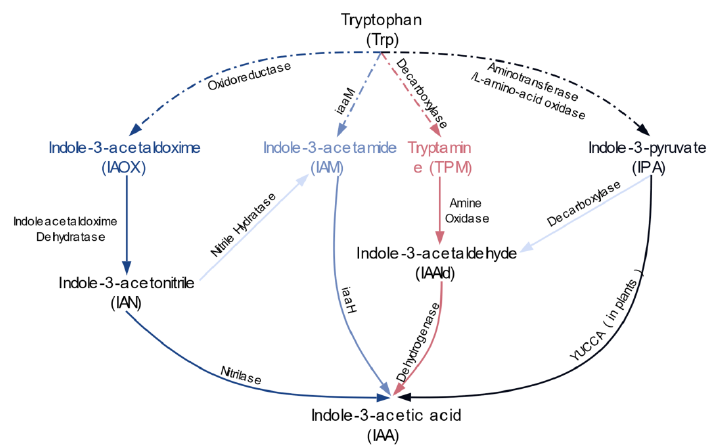
Figure 1. The major microbial Trp-dependent IAA synthesis pathways. Different pathways are depicted with different colors. In our study, we decompose each pathway into three parts: the first part represents the first step of IAA synthesis or the Trp-catalyzing step (dashed lines in the figure); the second part represents synthesizing IAA from Trp or the de novo IAA synthesis; the third part represents synthesizing IAA from intermediates (IPA, IAM, TPM,